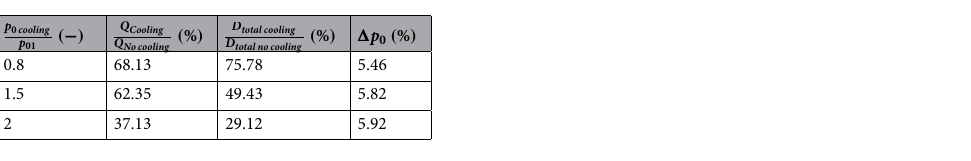
Table 5. Cooling performance summary of d cooling = d / 10 diameter injection port cases.